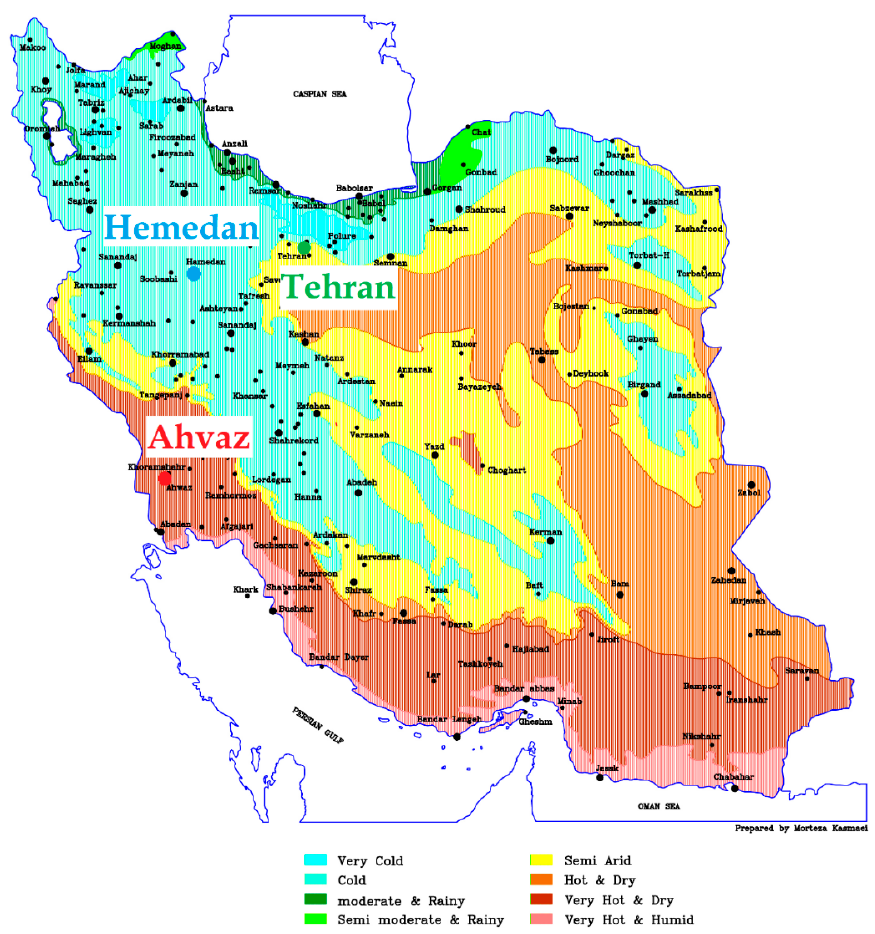
Figure 4. Climate map of Iran and the location of the selected cities [37]. Table 1. Ambient temperature and wind speed for the identified cities.